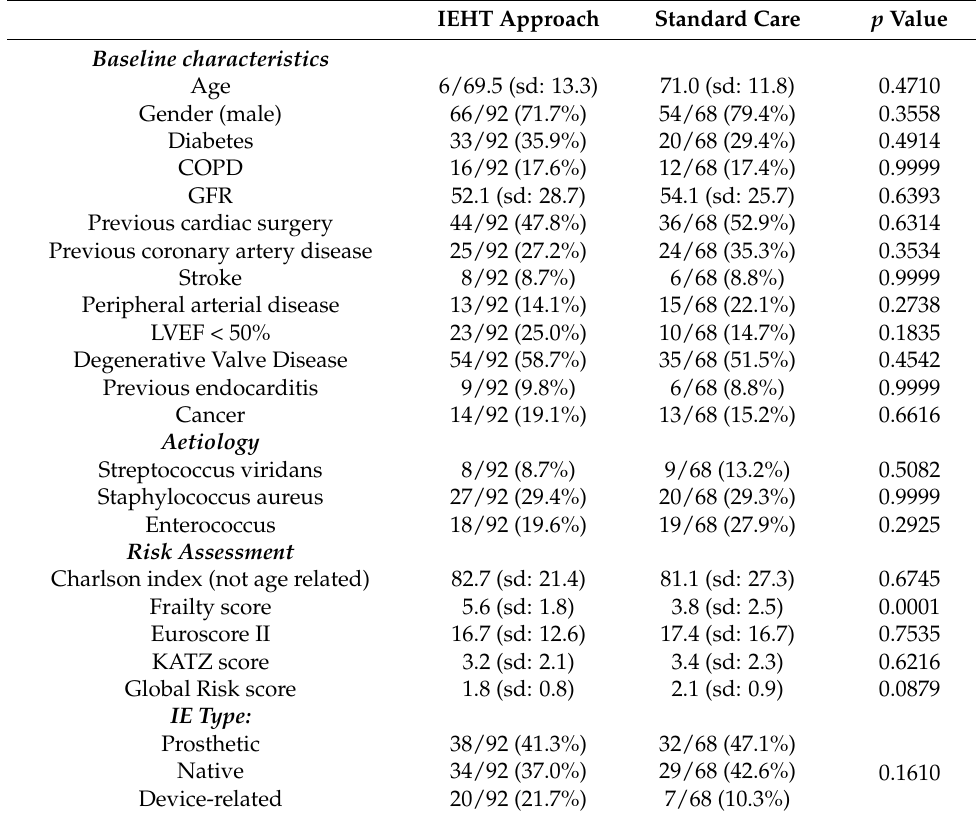
Table 4. Baseline clinical characteristics, aetiology, risk assessment and type of IE: IEHT approach versus standard care.